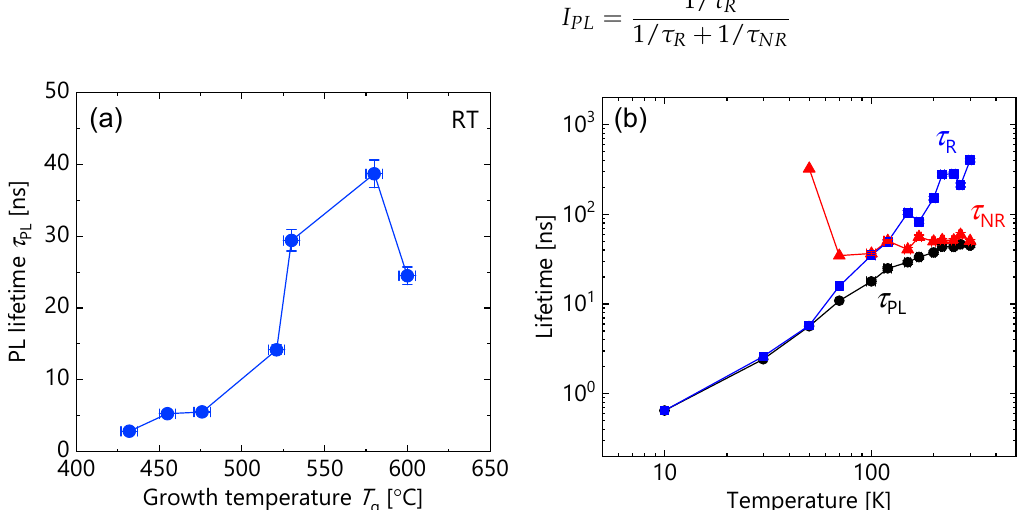
Figure 7. ( a ) Growth temperature dependence of PL lifetimes ( τ PL ) measured at RT. ( b ) Temperature dependence of PL lifetimes ( τ PL ; solid circles), radiative recombination time ( τ R ; solid squares) and non-radiative recombination time ( τ NR ; solid triangles) for the sample grown at T g = 580 °C.